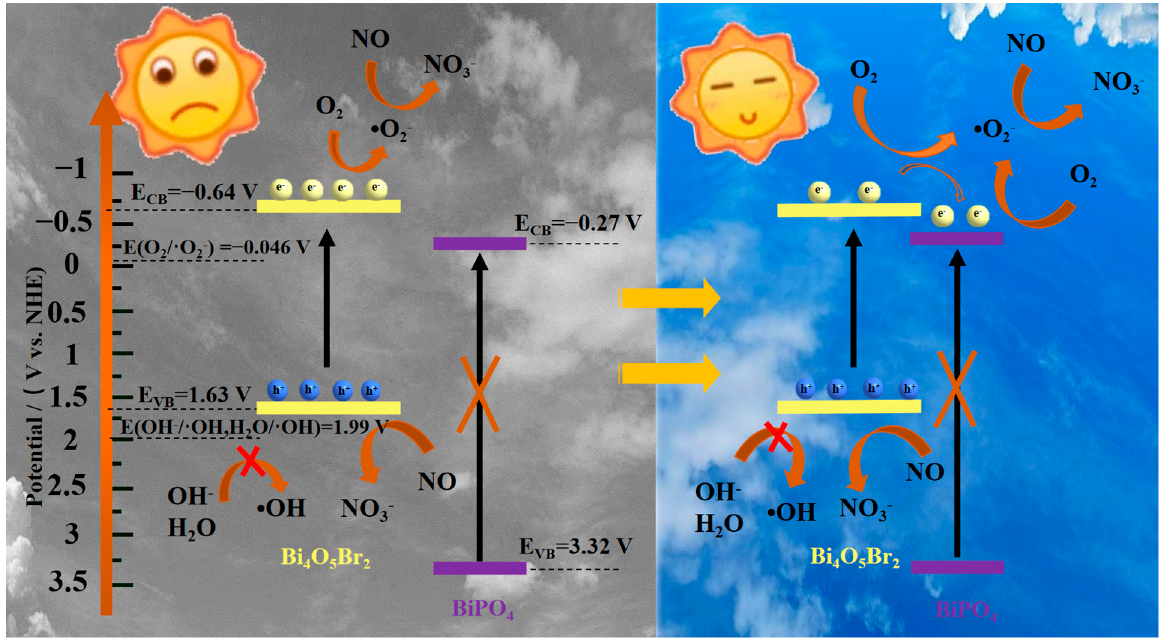
Figure 7. A proposed photocatalysis mechanism of the PBX series under visible light.